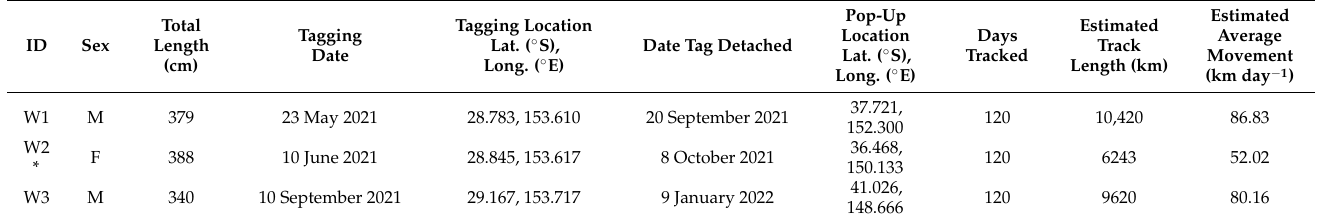
Table 1. Summary of biological details, tag deployment and tracking details for the three white sharks ( C. carcharias ) tagged off the northern New South Wales coast of eastern Australia. * MiniPAT tag